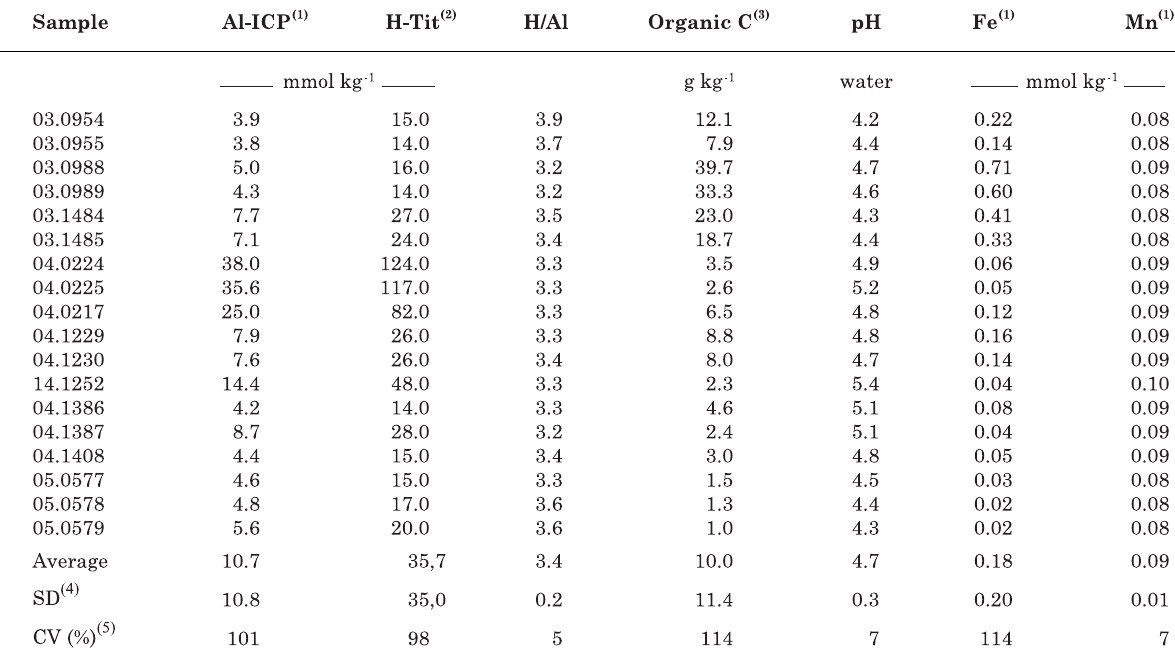
Table 2. Some chemical analyses of 18 mineral soil samples